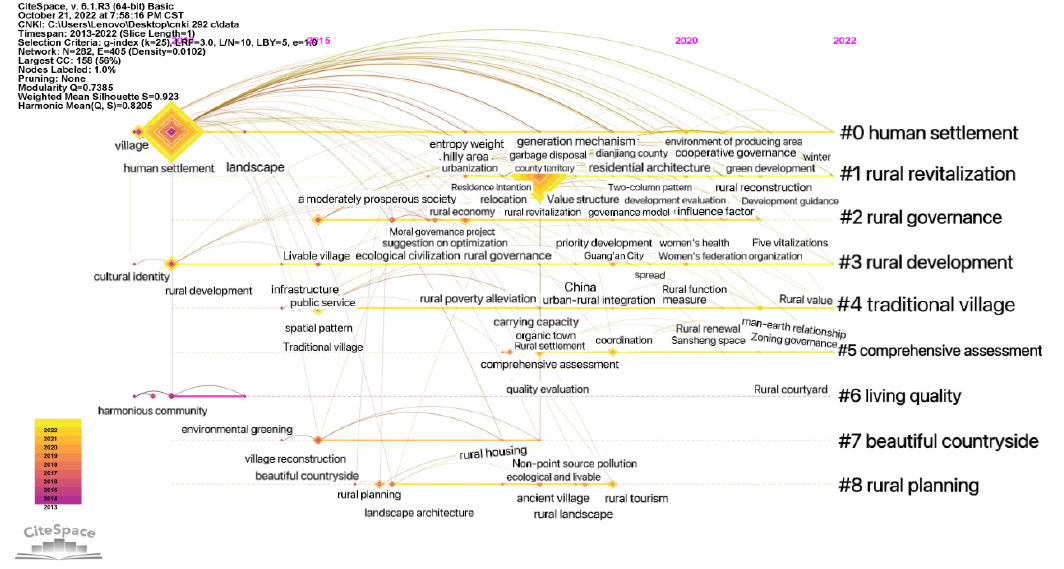
Figure 9. Timeline of keywords in rural human settlements research.